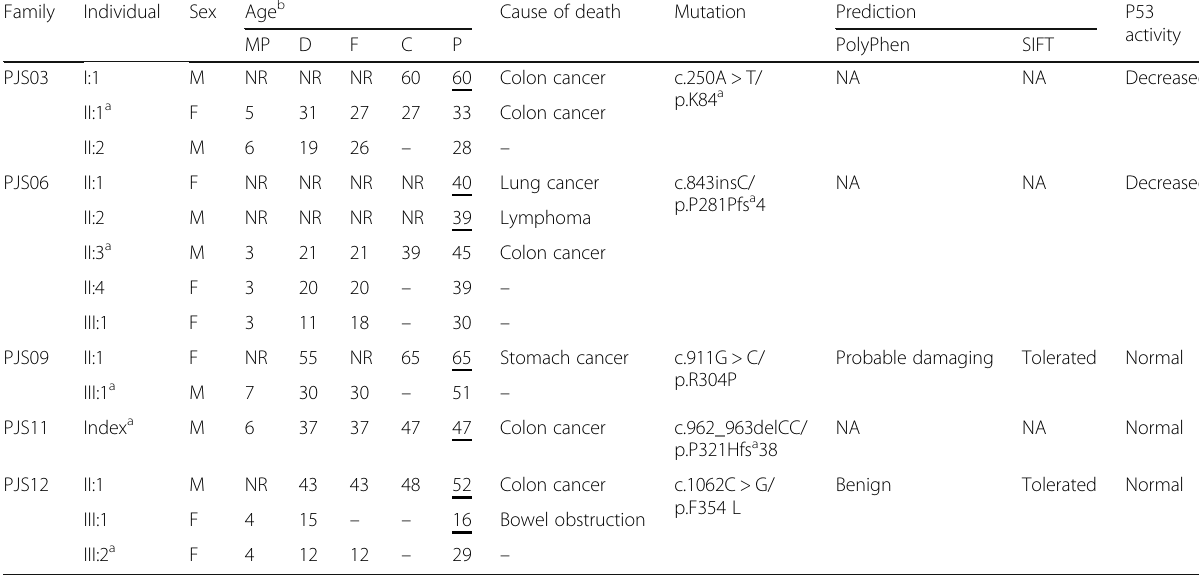
Table 3 Characteristics of affected individuals in PJS families with cancer history Family Individual Sex Age